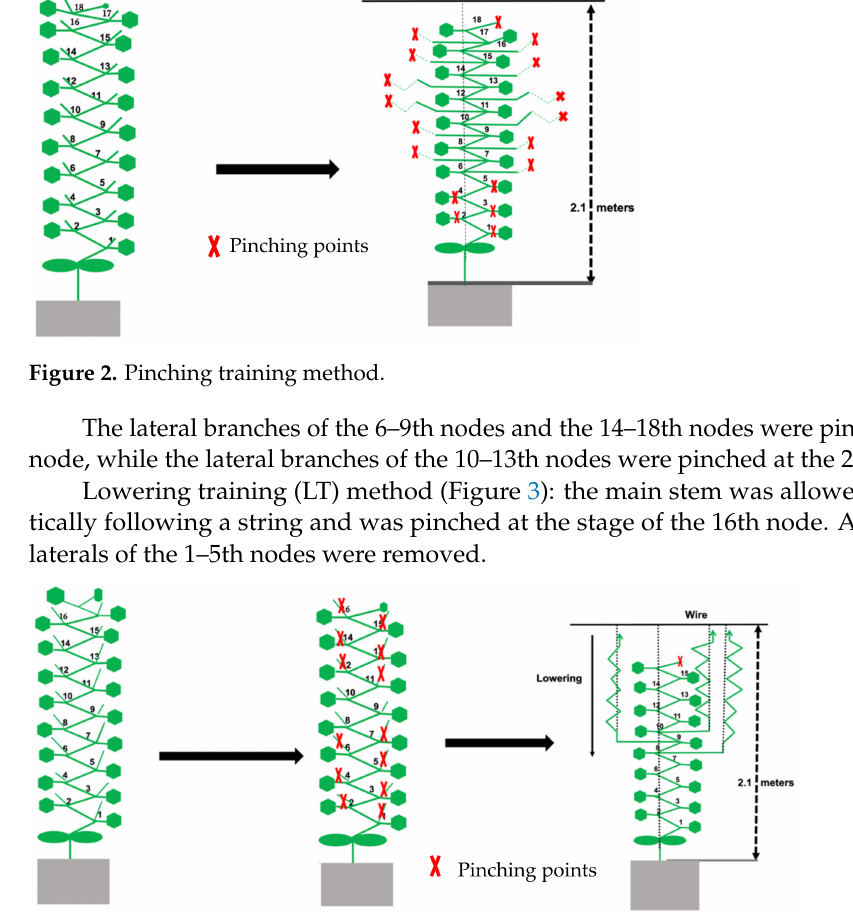
Figure 3. Lowering training